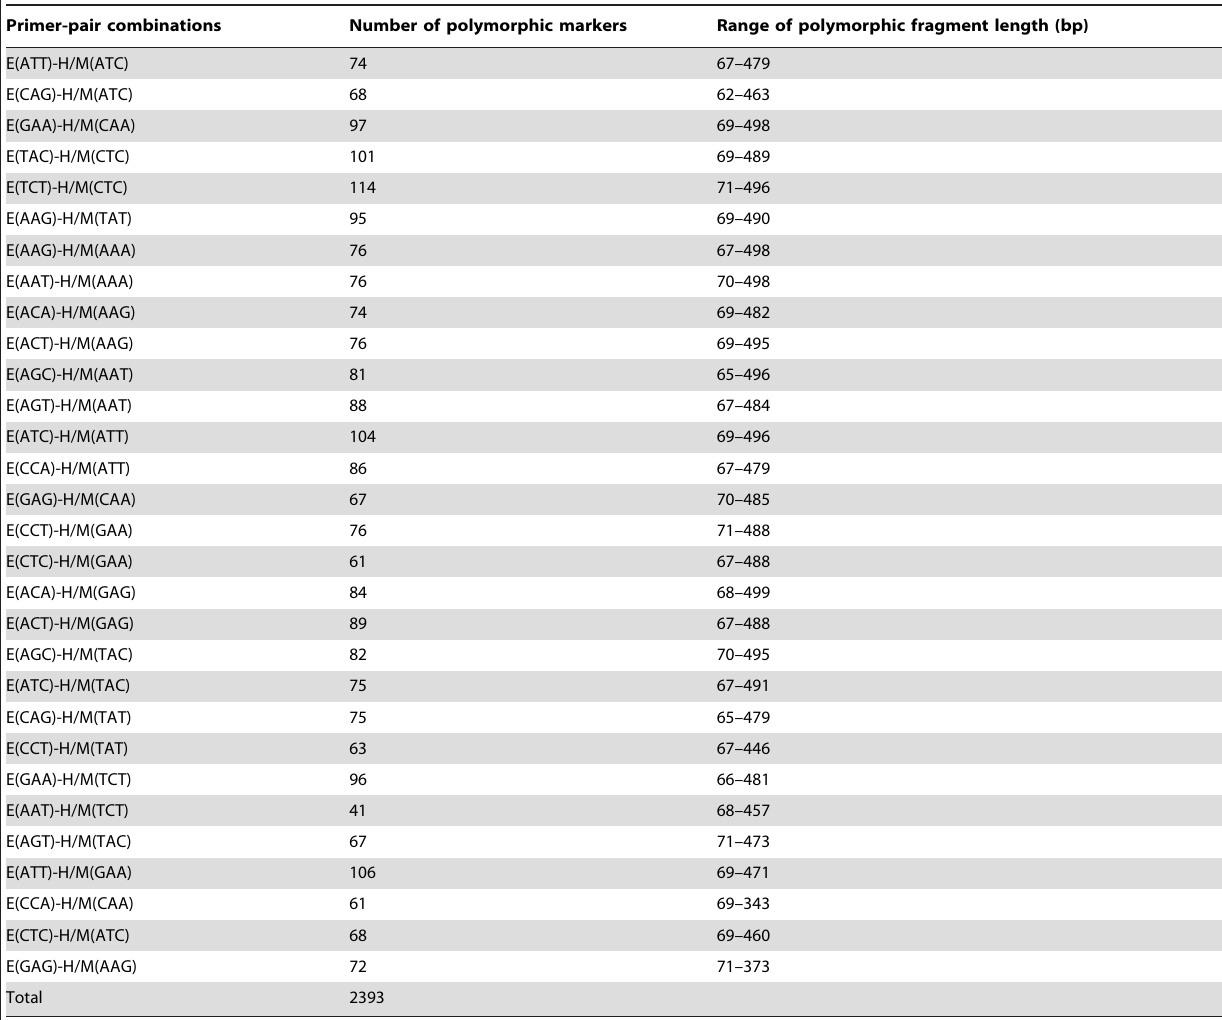
Primer-pair combinations Number of polymorphic